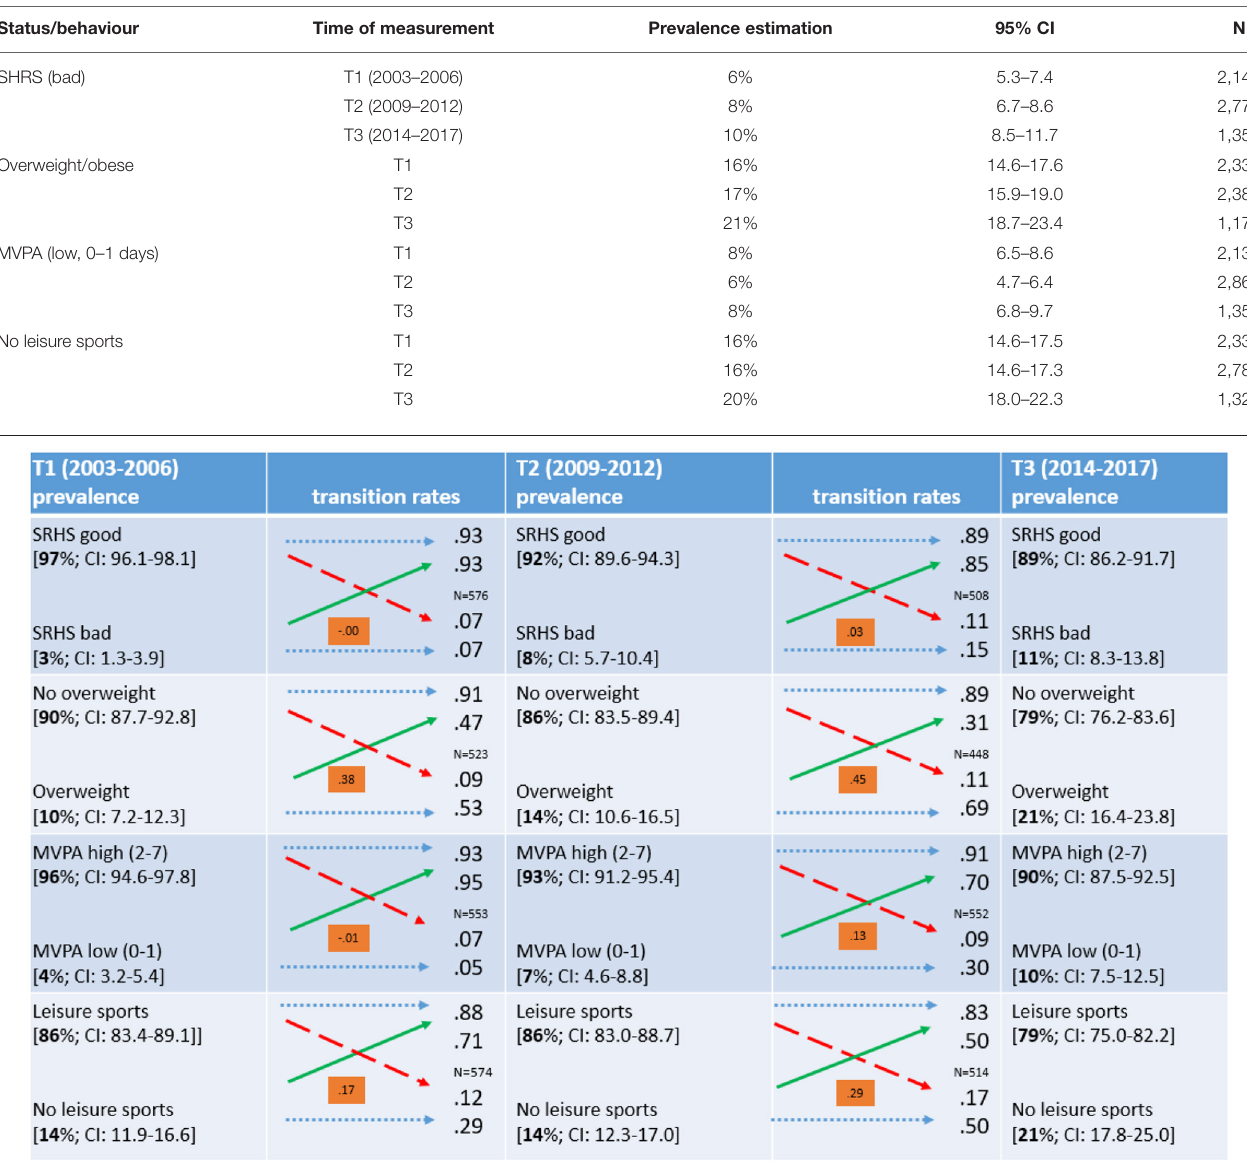
TABLE 2 | Prevalence estimators of problematic health status and unhealthy behaviour (cross-sectional data, adjusted for age composition). Status/behaviour Time of measurement Prevalence estimation